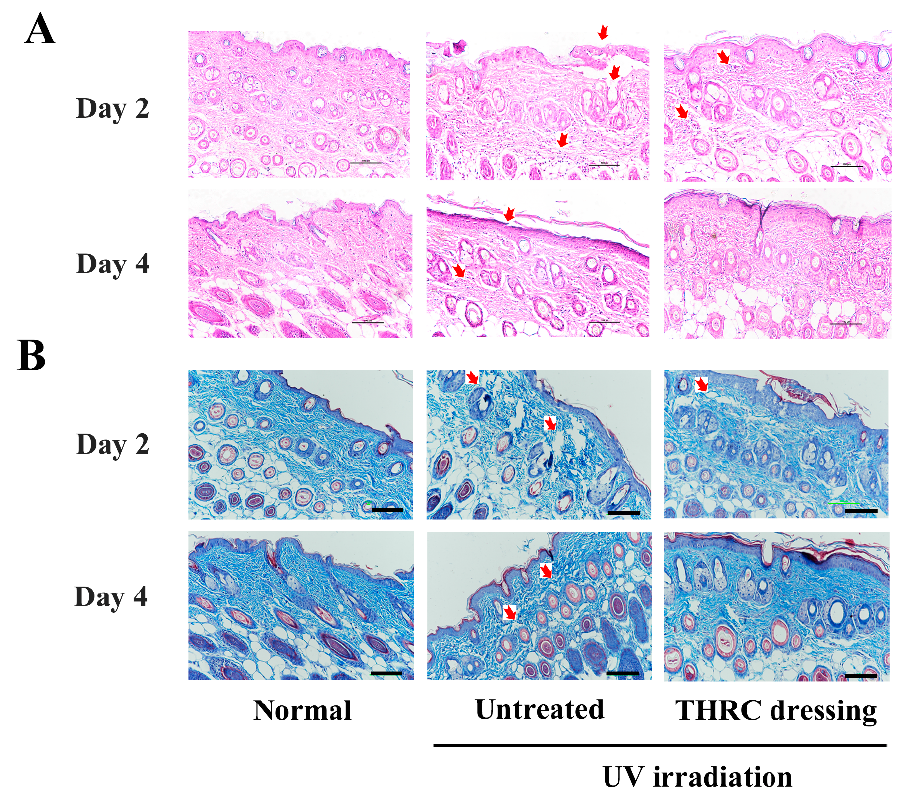
Figure 5. Histological analysis of normal skin and photodamaged mice acute wounds. ( A ) H&E staining and ( B ) Masson staining of skin tissues of the normal, the untreated, and the THRC dressing groups. The injuries in the epidermis and the dermis were noted by red arrows. Scale bar: 100 μ m. Table 2. Collagen fraction volume of skin tissues in the normal, untreated, and THRC dressing groups.